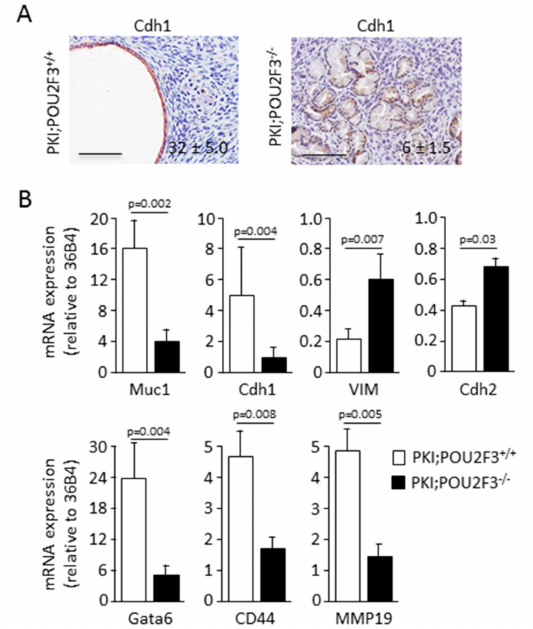
Figure 2. PDAC from PKI;POU2F3 − / − mice is more di ff erentiated. ( A ) Immuno-staining of Cdh1 in pancreas from PKI;POU2F3 +/+ and PKI;POU2F3 − / − mice. Values denote positive cells per field. ( B ) mRNA expression in pancreas from PKI;POU2F3 +/+ and PKI;POU2F3 mice. Scale set as 100 µ